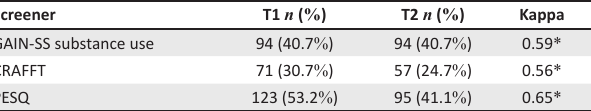
TABLE 3: Kappa levels of agreement above the cut-off score for substance use